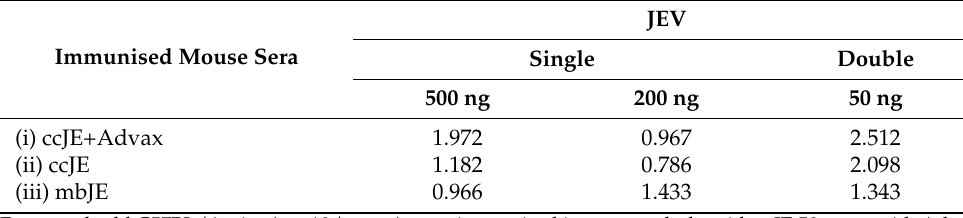
Table 4. Advax adjuvants induce strong neutralising antibodies against JEV in either a single or two dose vaccine